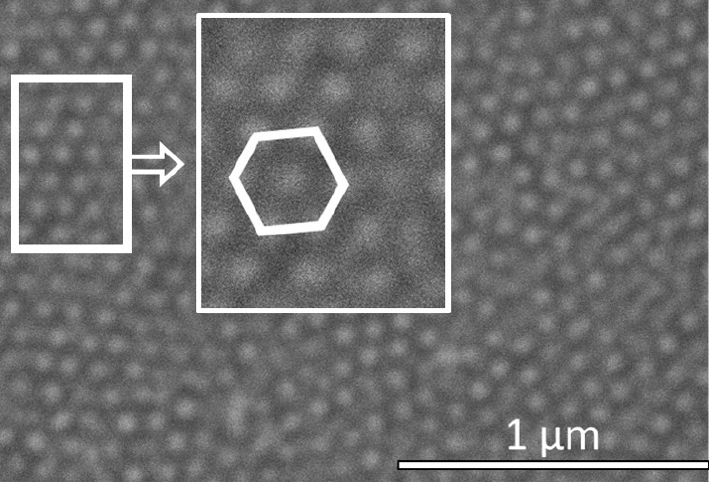
Figure 10. SEM image of indium nanoparticle array formed after evaporating 8 nm thick In film onto a dimpled surface fabricated at 40